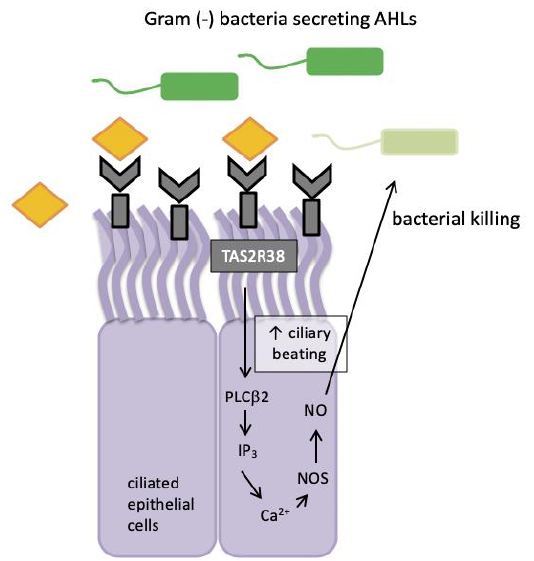
Figure 2. TAS2R38 bitter taste receptor regulation in human sinonasal epithelial innate immunity. AHLs = acyl-homoserine lactones; Ca 2+ = calcium ion; NO = nitric oxide; NOS = nitric oxide synthase; PLCβ2 = phospholipase; IP 3 = inositol trisphosphate.